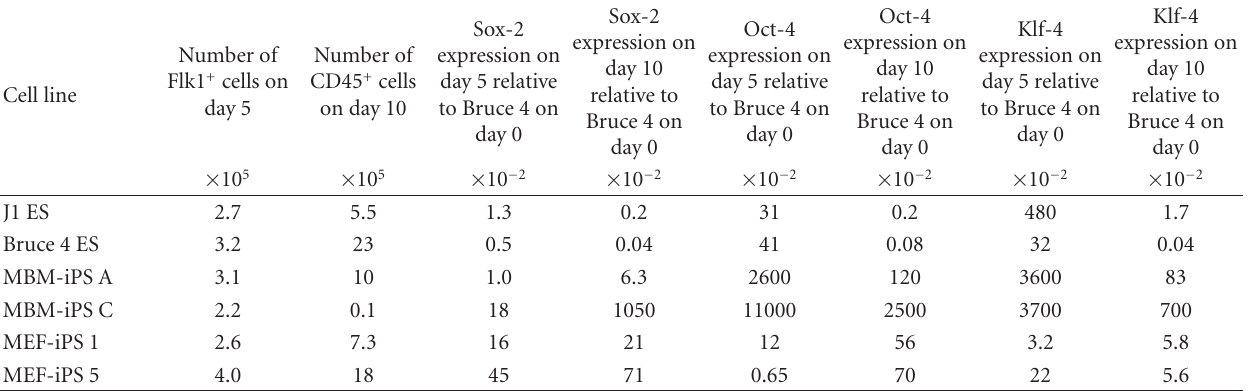
Table 1: Di ff erentiation of MBM- and MEF-derived iPSC lines in comparison to ESC lines. Numbers of cells indicate those developed from 4 × 10 3 undi ff erentiated cells (day 0). Expression levels represent amounts of mRNA determined by quantitative RT-PCR, normalized to GAPDH expression, and calculated as expression values of the respective genes in undi ff erentiated Bruce4 ES cells (day